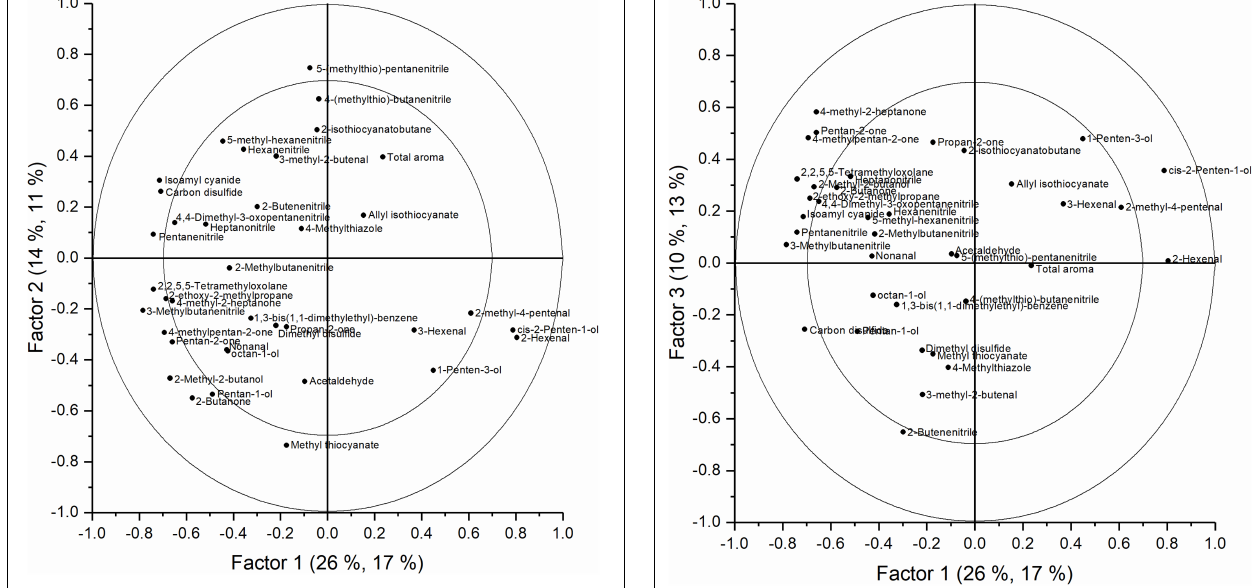
increased during storage under high O 2 and low CO 2 levels and also increased during storage. Nitrile levels also changed during storage under CA. In general, higher levels of nitriles were found at the end of the storage, but no clear pattern is found for the effect of O 2 and CO 2 on their concentration. In Supplementary Table 2 the relative values of all aroma compounds considered are shown per treatment and storage